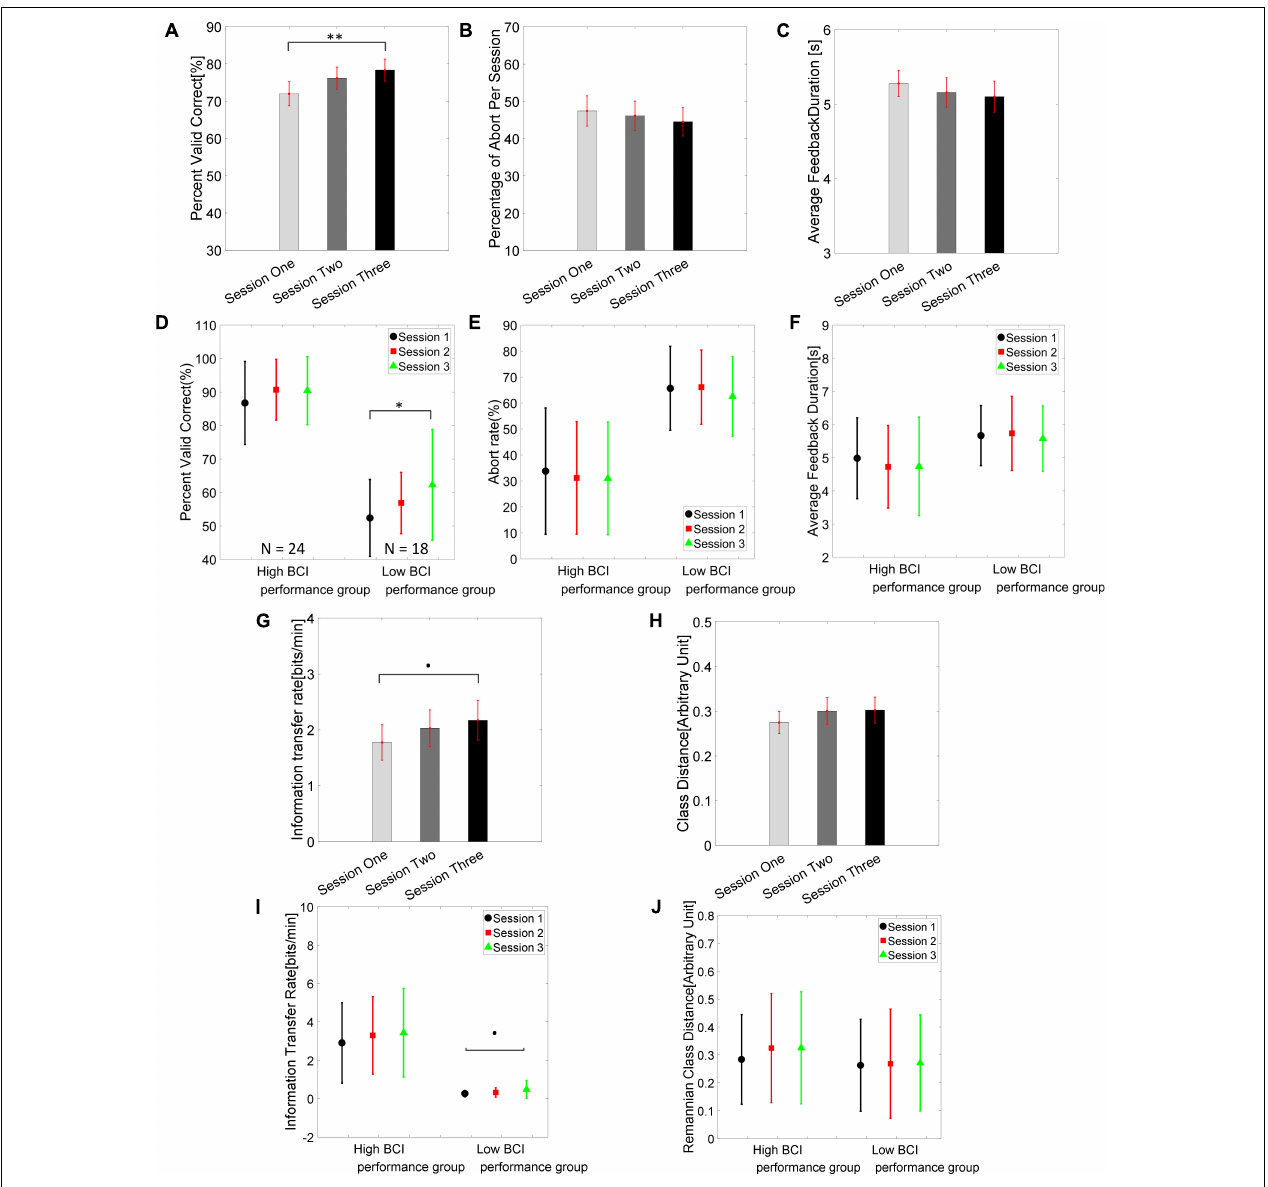
FIGURE 2 | Brain-computer interface behavioral performance. (A) Group average PVC ± standard error of the mean (SEM) of 42 subjects across the three training sessions. The statistical analysis showed there was a significant difference of PVC between sessions 1 and 3 ( ∗∗ p = 0.004, Tukey’s HSD post hoc test). (B) Group average percent of abort rate ± SEM across the three training sessions. (C) Group average feedback duration ± SEM across the three training sessions. (D–F) Group average PVC, abort rate, and feedback duration in high BCI performance group (average PVC across three session > =70%, N = 24) and low BCI performance group ( < 70%, N = 18). (G) Group average information transfer rate (ITR) ± SEM across three sessions. (H) Group average class Riemannian distance ± SEM across three sessions. (I,J) Group average ITR and class Riemannian distance in high and low BCI performance groups. ∗ p <